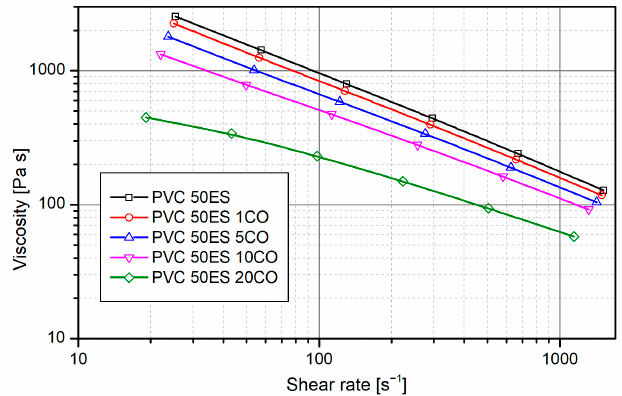
Figure 2. Viscosity curves for materials with di ff erent cassia oil contents.